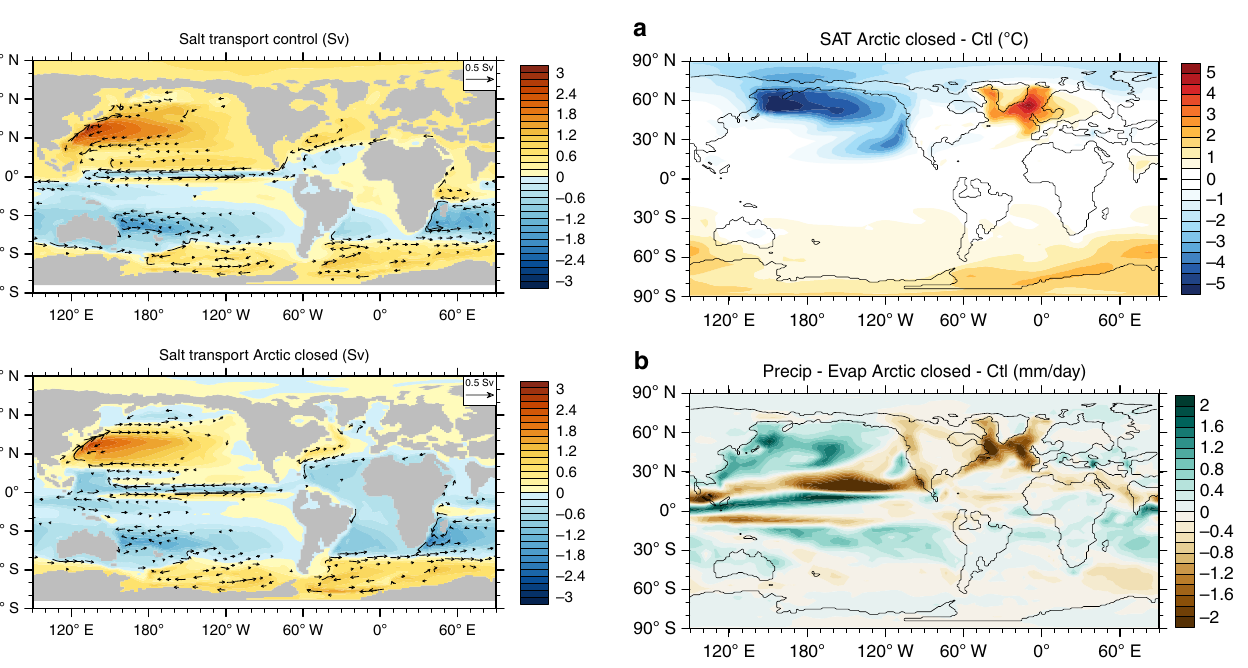
Fig. 5 Temperature and freshwater fl ux response to closing the Arctic gateway. a Surface air temperature (SAT) and b precipitation minus evaporation differences showing the Arctic closed — control experiment in each case. There is substantial cooling (>5 °C) of the North Paci fi c in response to the shutdown of Paci fi c sinking, and a corresponding warming of the North Atlantic. No major interhemispheric temperature change is found. Precipitation minus evaporation increases in the North Paci fi c and decreases in the North